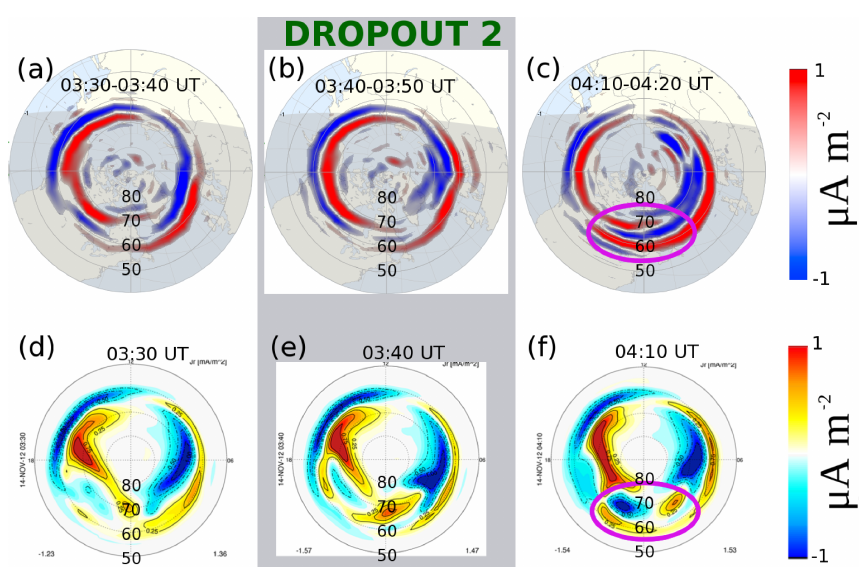
Figure 4. AMPERE-derived Birkeland currents and model Birkeland currents sampled to reflect dynamics before, during, and after dropout 2. The format is the same as for Fig. 4.